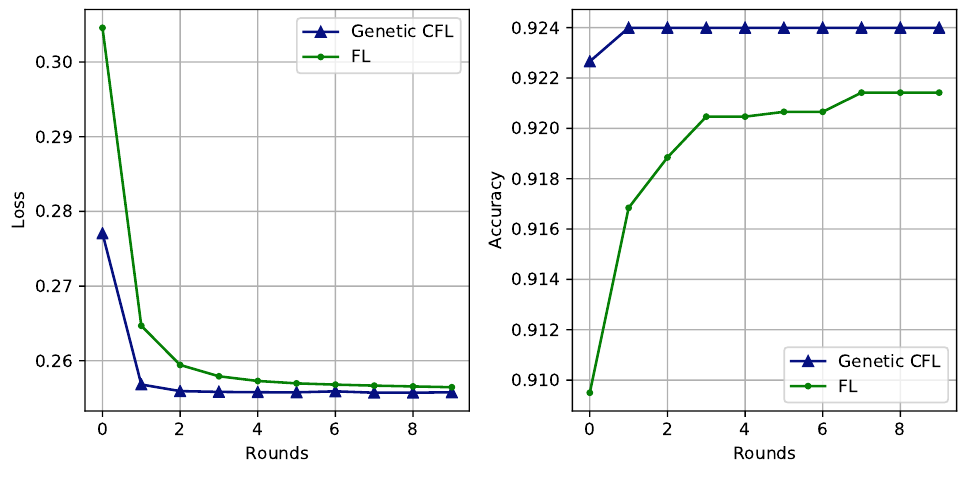
Figure 2. Evaluation of Loss and Accuracy on COVID-19 dataset- FL vs Genetic CFL.